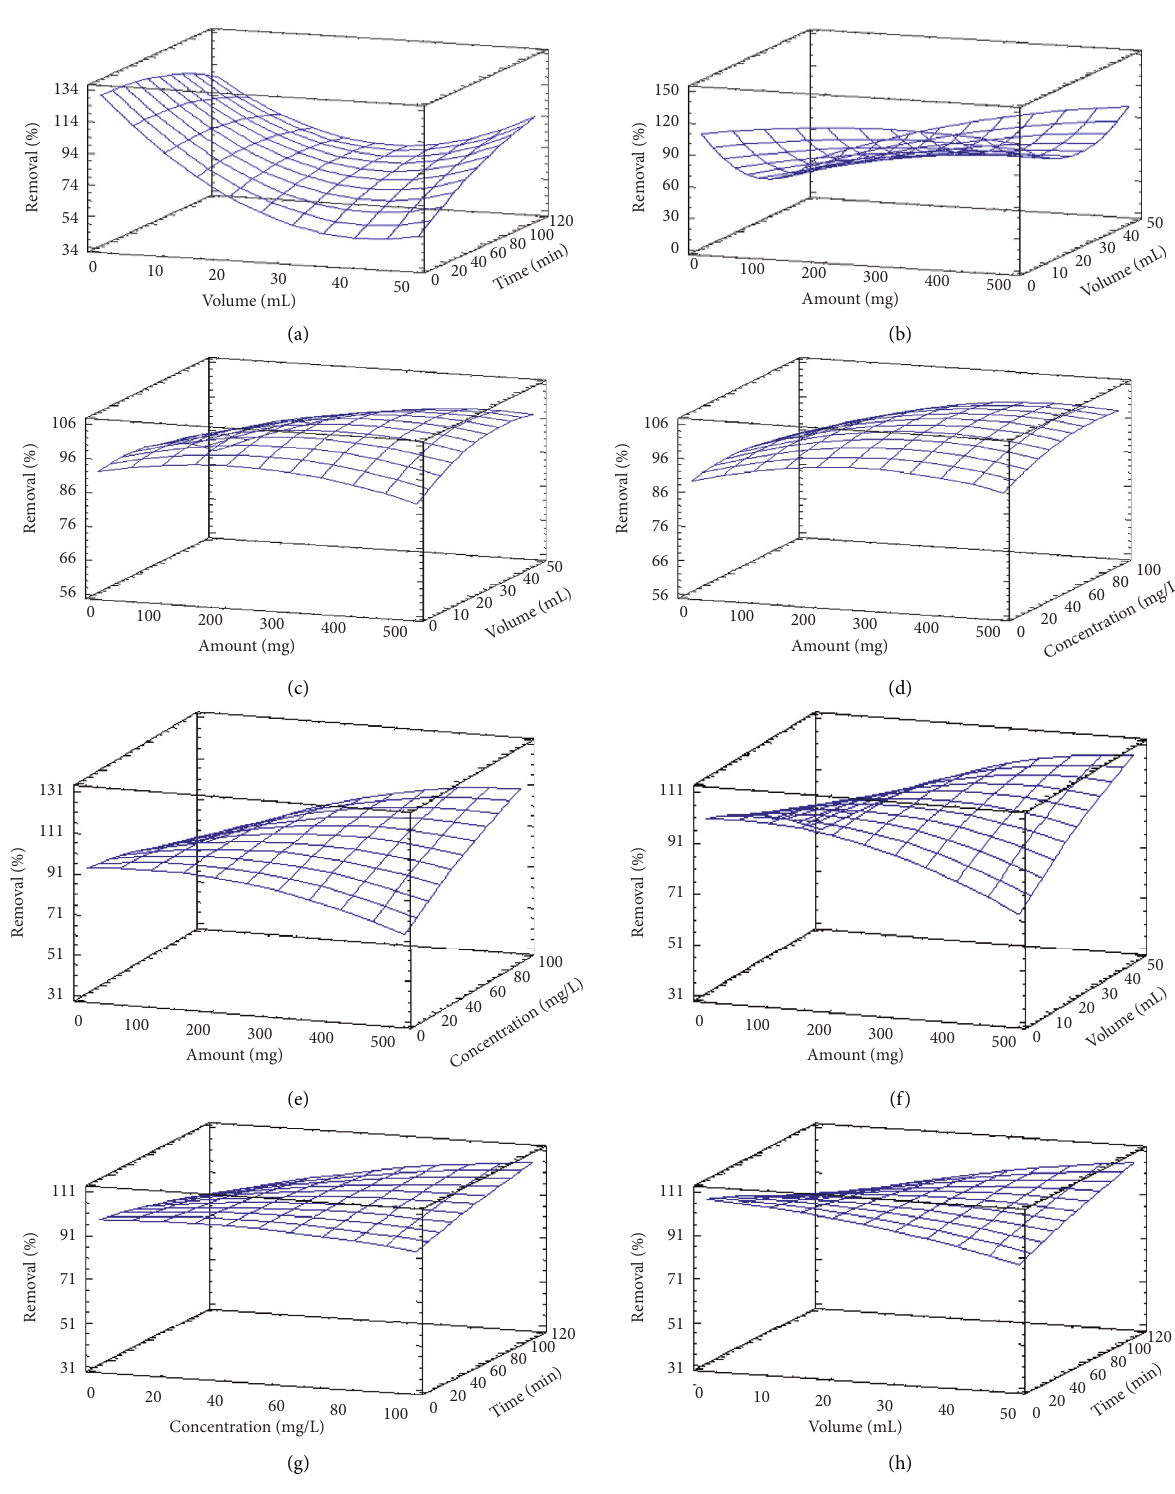
Figure 9: 3D response surface plots for MB (a and b), MO (c and d), and RY-2